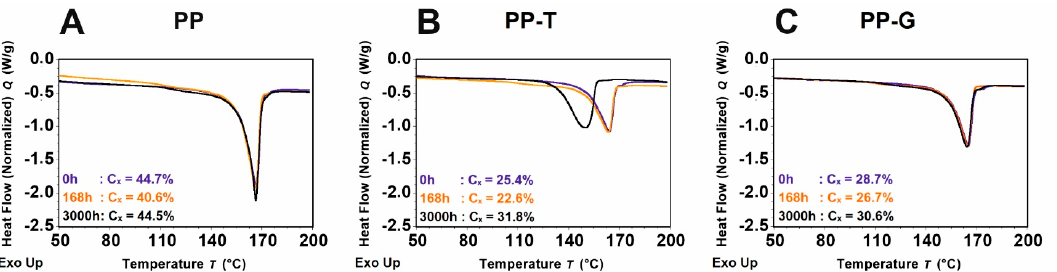
Figure 3. DSC graphs of samples ( A ) PP, ( B ) PP-T and ( C ) PP-G after 0 h, 168 h and 3000 h, respectively, with corresponding crystallinity. Minimum of the heat flow corresponds to the melting temperature.